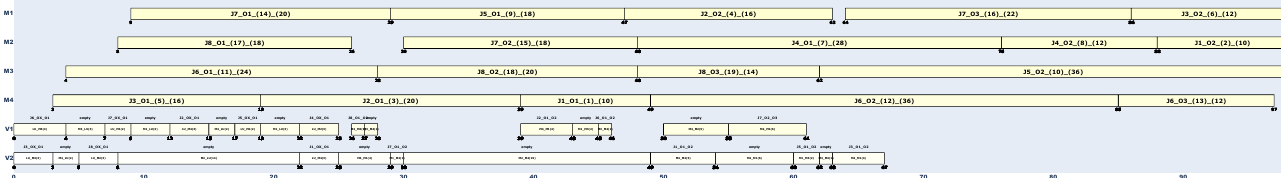
Figure 6. Gantt chart for improved solution of EX_710 instance from Kumar, Janardhana and Rao [11].